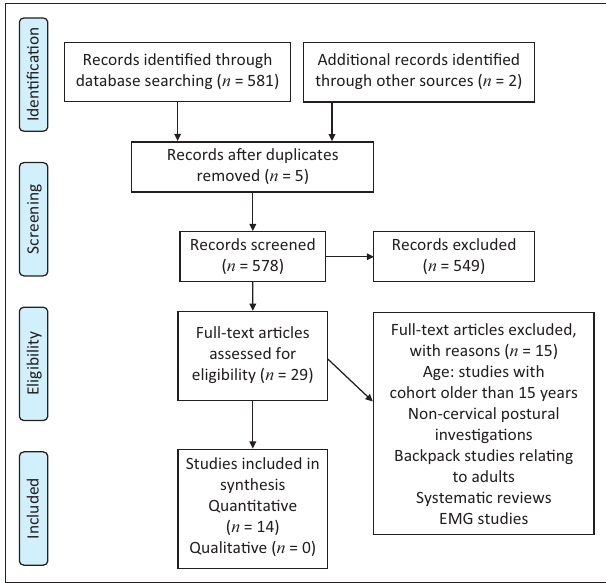
FIGURE 1: Conceptualisation of the review